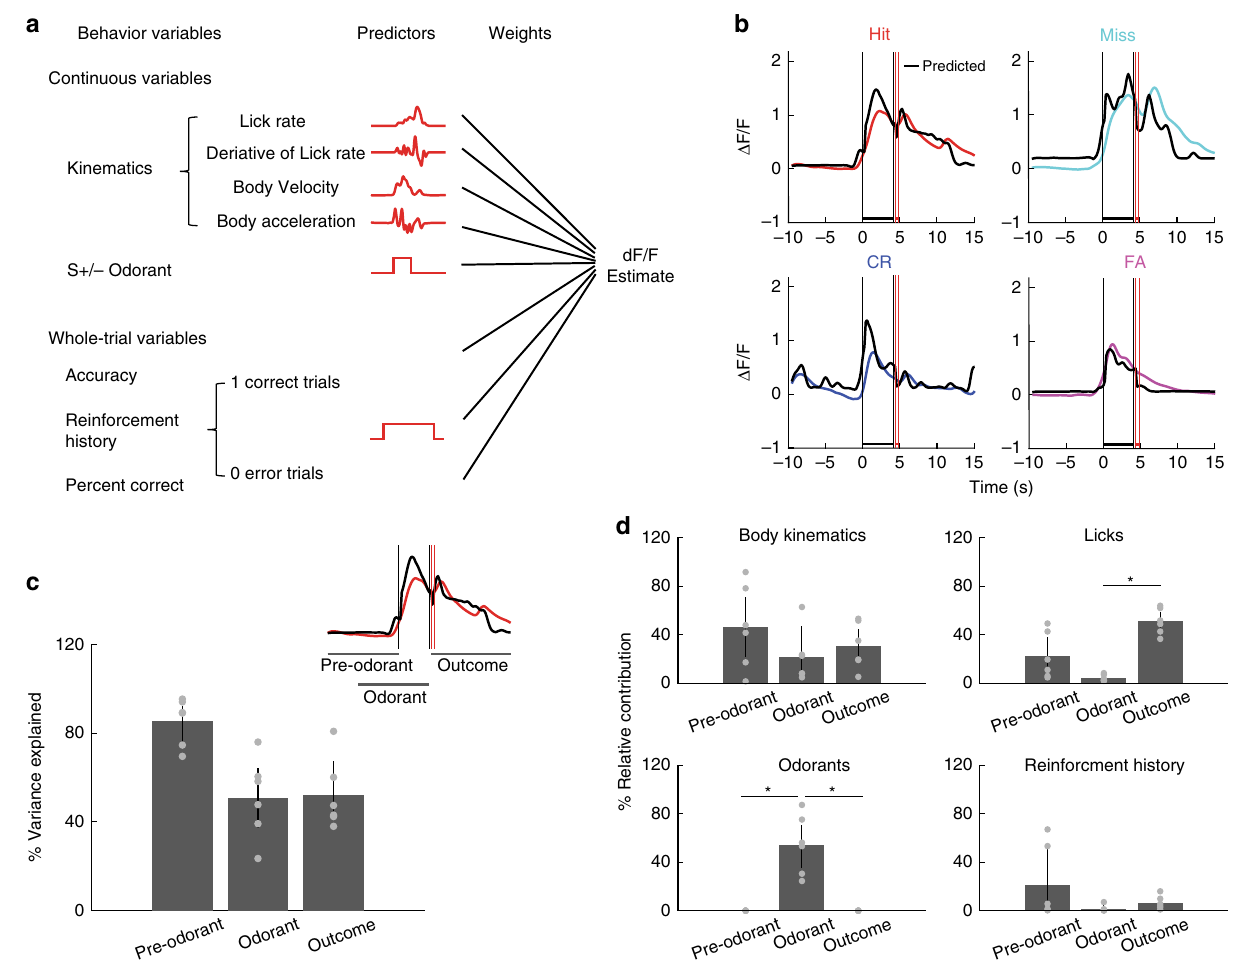
Fig. 6 Fit of MLI activity with a generalized linear model. a Schematic illustration of the variables used by the GLM model to quantify the relationship between average Δ F / F and behavioral variables and odorant valence on a per trial basis. b Examples of GLM best- fi t (black) and actual Δ F / F Ca 2 + traces for Hit (red), Miss (cyan), CR (blue), and FA (magenta) trials. The vertical black lines are odorant onset and removal and the red lines bound the reinforcement period. c Percent of the variance explained by GLM in the different time periods (Pre-odorant, odorant and outcome, n = 6 sessions, 5 mice, error bars are 95% CIs). The inset shows the time intervals used for the different periods. d Relative contribution of kinematics, licks, odorants, and reinforcement history to the GLM fi t for fi ts in the different time periods (pre-odorant, odorant, outcome). The results showed that odorants and licks play an important role in contributing to the activity during odorants and outcome periods, respectively, while kinematics contribute to the activity in all three time periods. Asterisks for licks (upper right panel) and odorants (lower left panel) denote signi fi cant differences determined by ranksum and two-sided t test ( p < pFDR = 0.033, n = 6 sessions, 5 mice). There are no signi fi cant differences for Kinematics or Reinforcement history ( p > pFDR = 0.017, ranksum test). Error bars are 95%